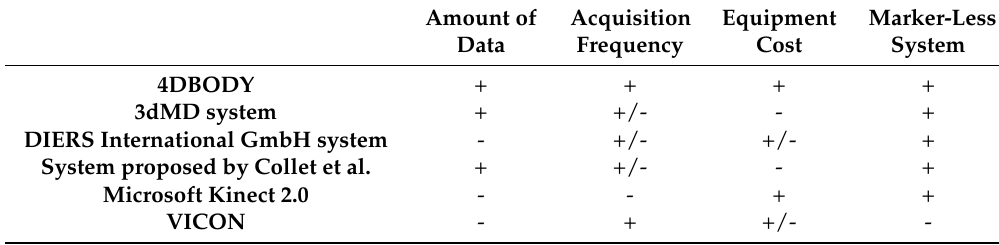
Table 2. Comparison of the 4DBODY system with the previously proposed systems. Amount of Acquisition Equipment Marker-Less Data Frequency Cost System 4DBODY + + + + 3dMD system + +/- - + DIERS International GmbH system - +/- +/- + System proposed by Collet et al. + +/- - Microsoft Kinect